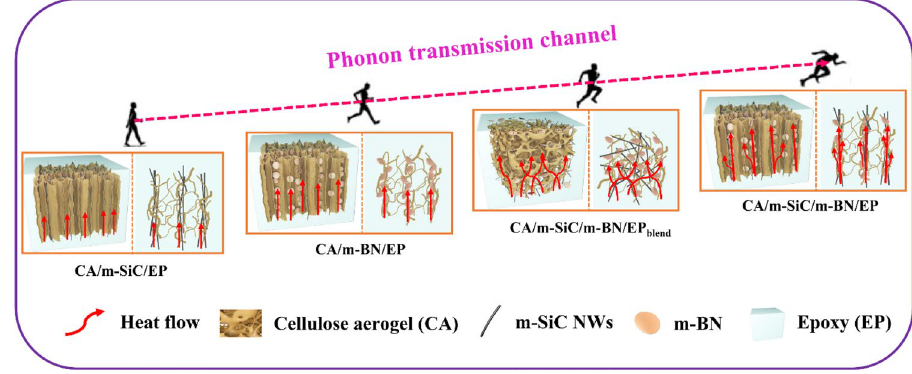
Fig. 8 Schematic diagram of heat flow of different EP‑based composites along the vertical direction